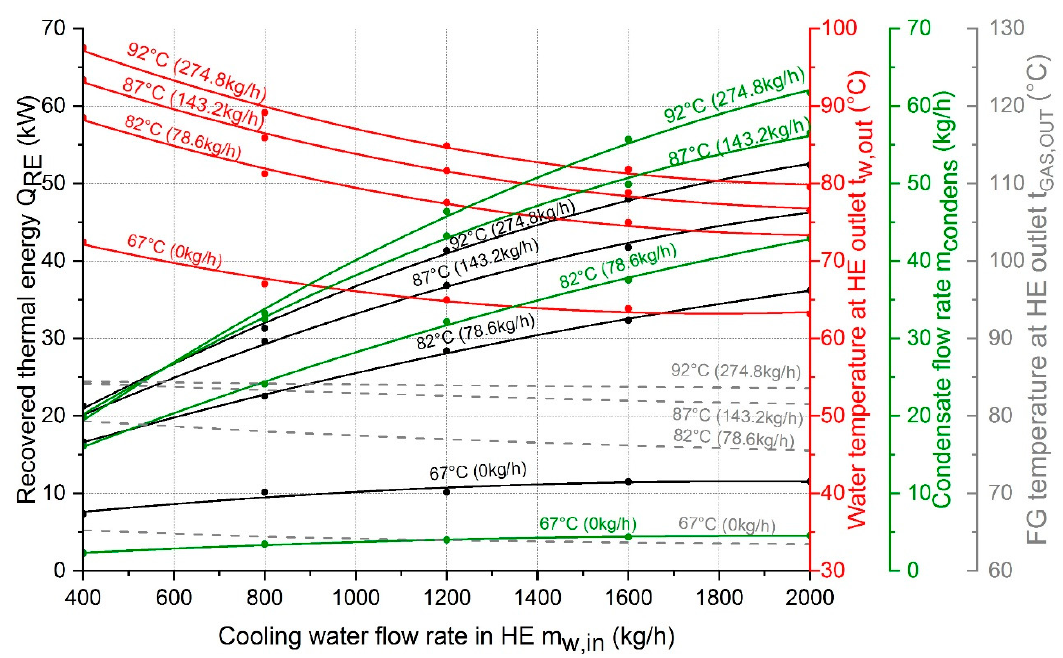
Figure 6. Influence of the cooling water flow rate in the HE and the dew point temperature on the recovered thermal energy (black lines), the water temperature at the HE outlet (red lines), the condensate flow rate (green lines) and the flue gas temperature at the HE outlet (gray lines) for concept 2.